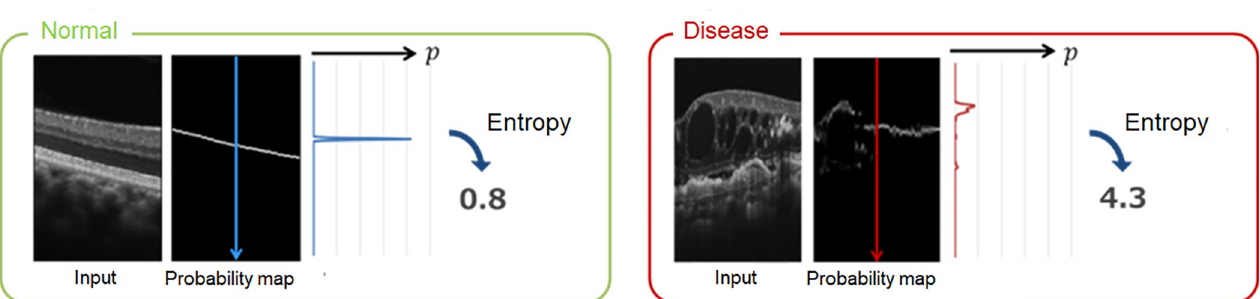
Fig 2. Conceptual diagram of the entropy value of each point in OCT A-scan. The OCT A-scan line in the normal eyes was blue, and in the disease-affected eyes, the scan line was red. In normal eyes, the probability distribution does not vary, so the entropy is small; however, in disease-affected eyes, the variation is large, so the entropy value is